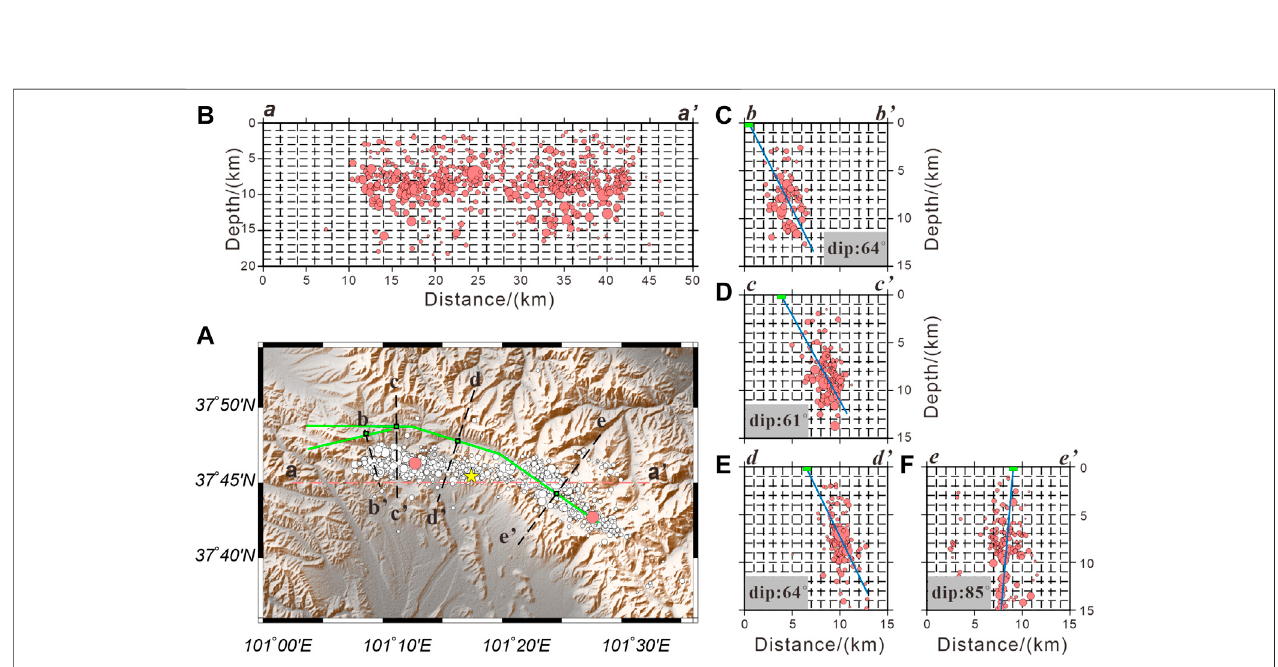
FIGURE 10 | Dip angles determined from aftershock pro fi les of different fault sections. (A) Green lines, the yellow star and pink circles denote the seismogenic faults, the epicenter of the mainshock and two aftershocks with magnitude ≥ 5.0, respectively. (B – F) represent the fi ve aftershocks pro fi les (aa ’ , bb ’ , cc ’ , dd ’ , ee ’ ). Fault positions are marked by the green